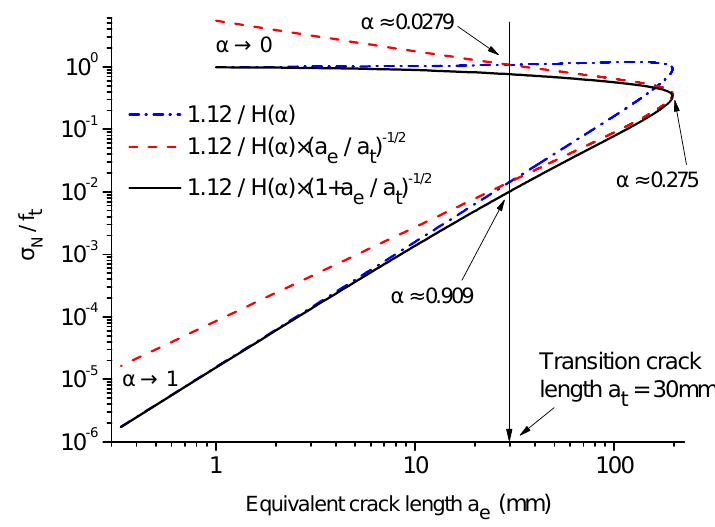
Figure 7. Nominal strength to tensile strength ratios versus equivalent crack length a e .